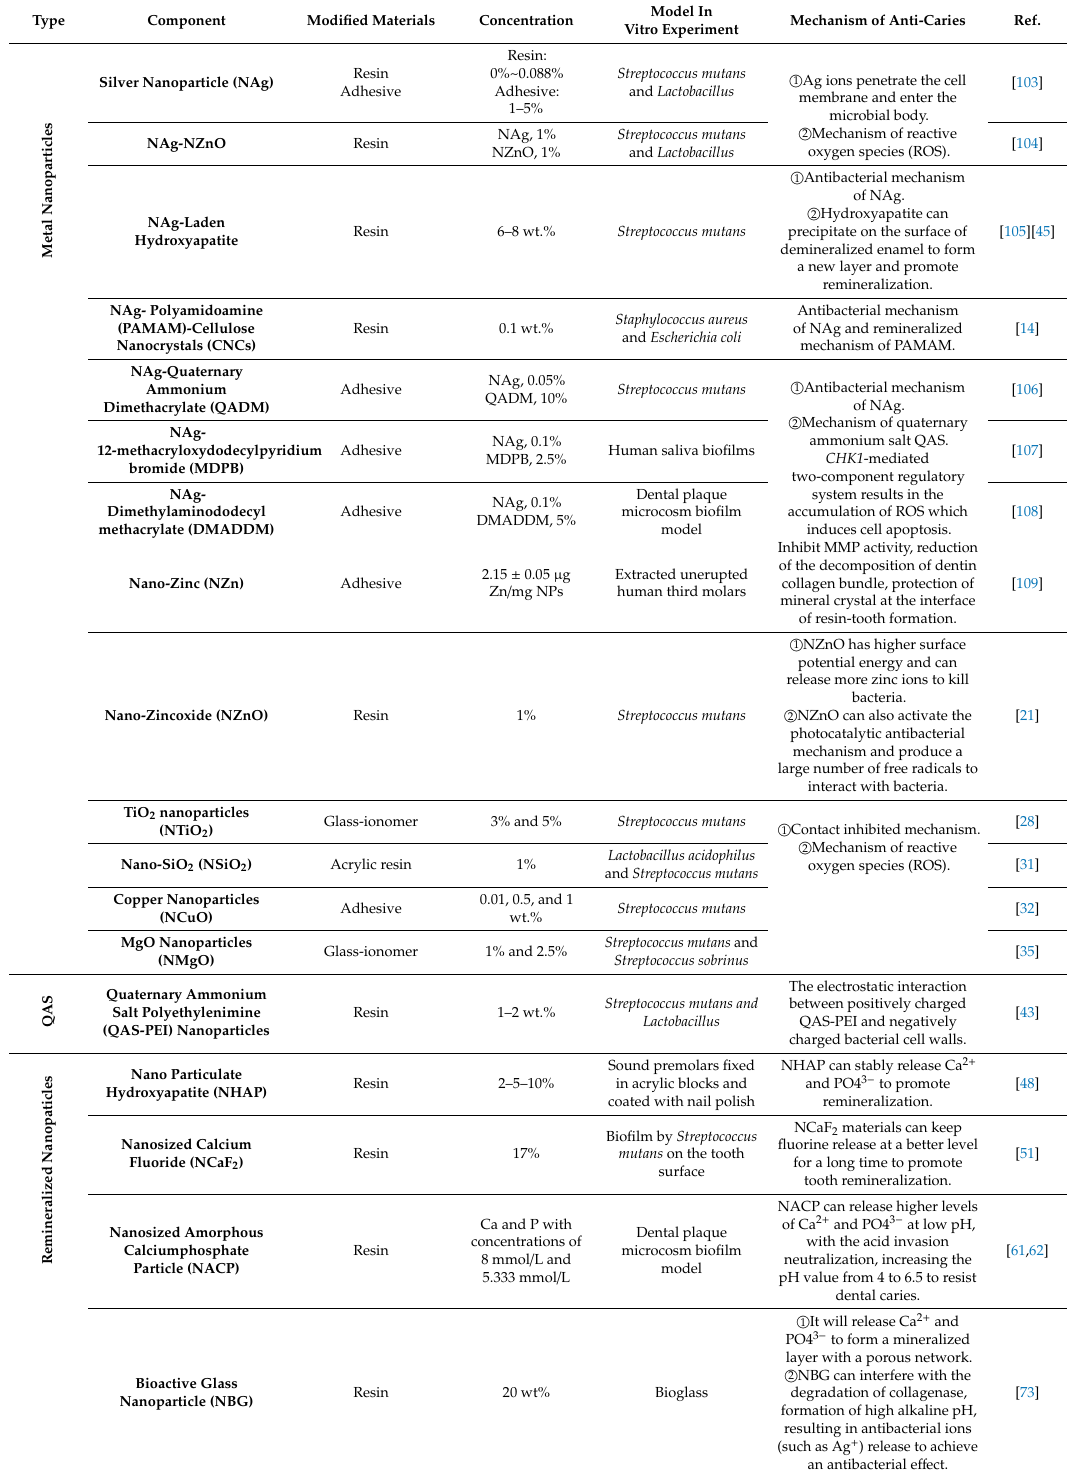
Table 1. The anti-caries component of